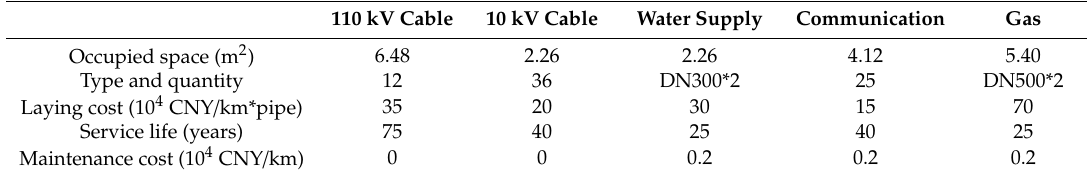
Table 2. Engineering parameters of traditional buried pipelines.